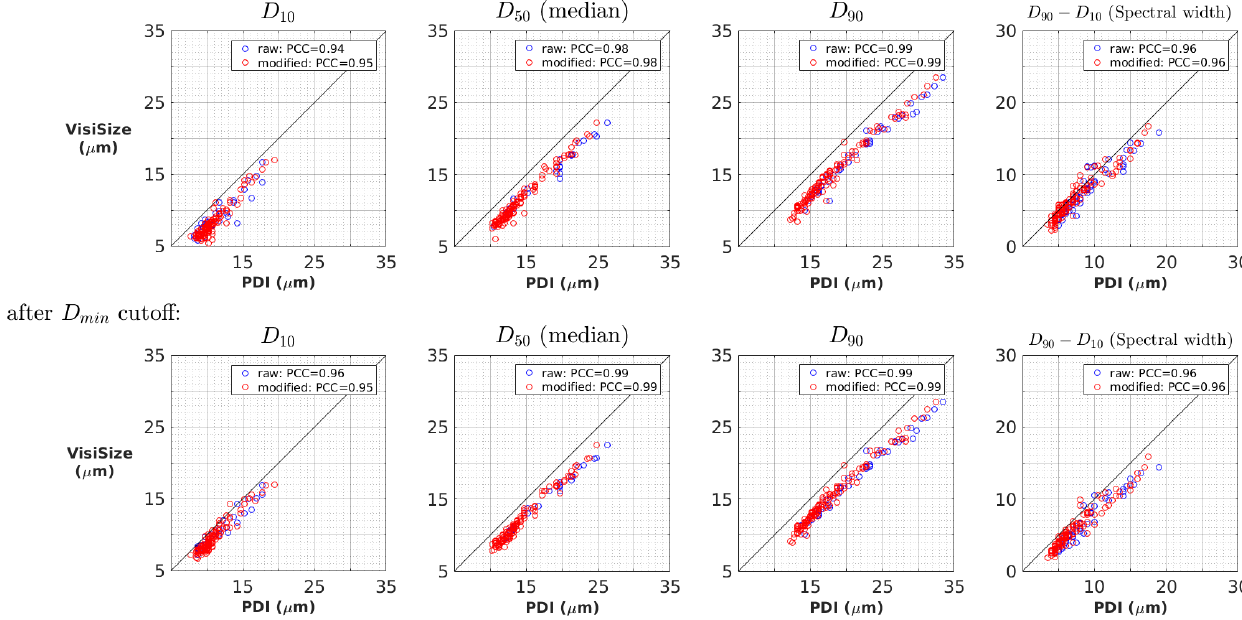
Figure 7. Comparison between the VisiSize and the PDI probe regarding the diameter size percentiles ( D 10 , D 50 , and D 90 ) as well as the spectral width ( D 90 − D 10 ) of cloud droplets. Each pair of blue and red circles indicates the raw/modified data for a selected measurement of ∼ 15min. The second row shows each plot after applying the D min cutoff to the data. PCCs are also shown in the